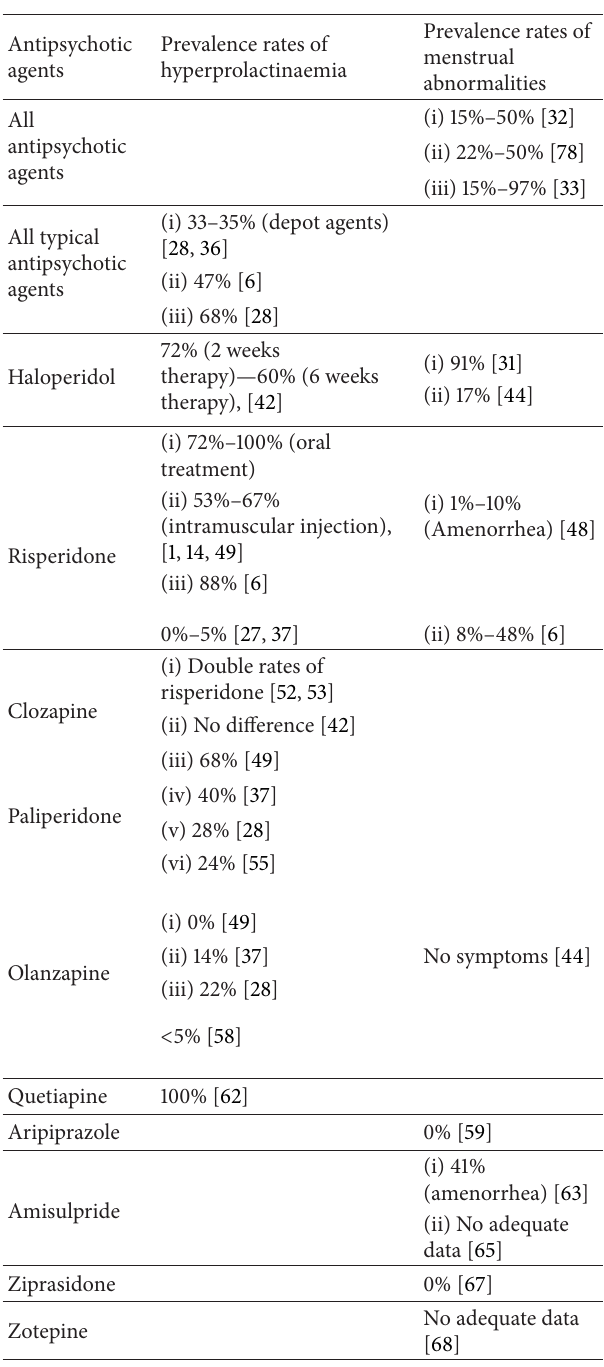
Table 1: Frequency of antipsychotic induced hyperprolactinaemia and menstrual abnormalities according to different